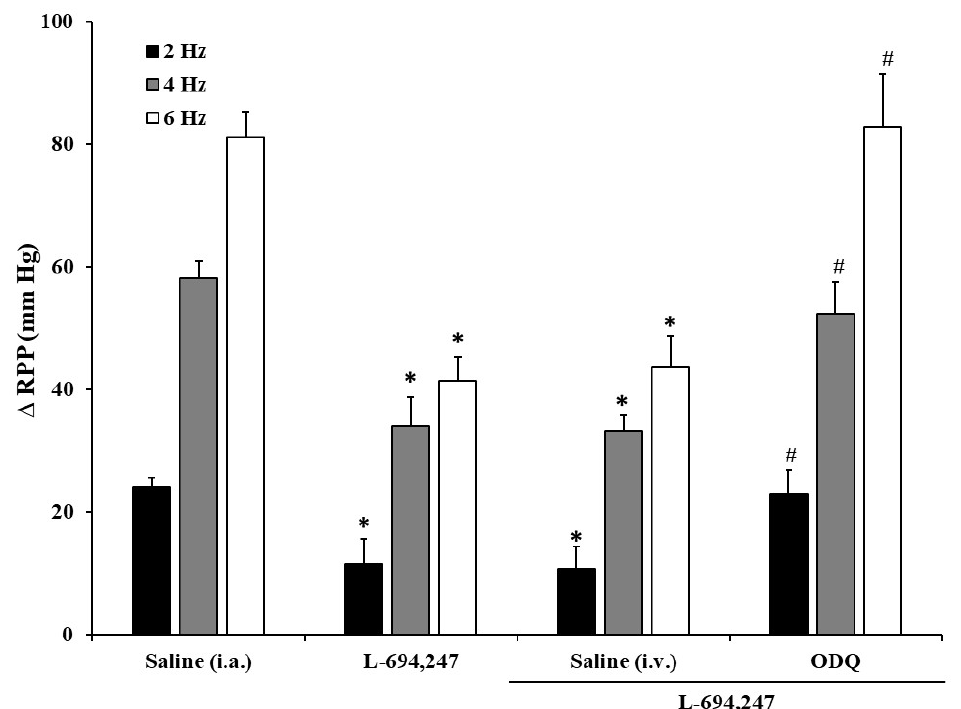
Figure 6. Effect of i.v. administration of ODQ on the 5-HT 1D agonist inhibitory action of the renal vasopressor responses in diabetic rats. Effect of i.a. bolus of saline (10 μL) or L-694,247 (0.4 μg/kg) in the absence or the presence of i.v. pretreatment with saline (1 mL/kg) or ODQ (10 μg/kg) on the vasopressor responses elicited by electrical stimulation of renal sympathetic nerves in diabetic rats. * p < 0.05 vs. saline i.a.; # p < 0.05 vs. L-694,247.